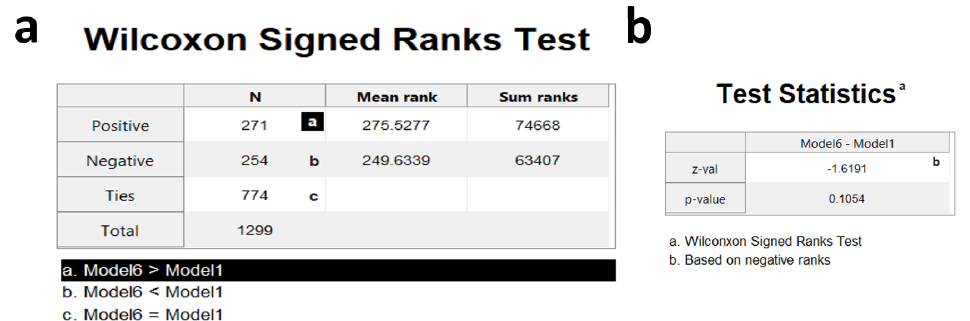
Figure A4. Wilcoxon signed rank test. ( a ) The Wilcoxon signed rank test table shows the difference that exists in two related samples through positive, negative and tie ranges. ( b ) p -value obtained with Wilcoxon rank test was 0.1054 less than the significance value of 0.05, so it was concluded that there was not a statistically significant difference between both